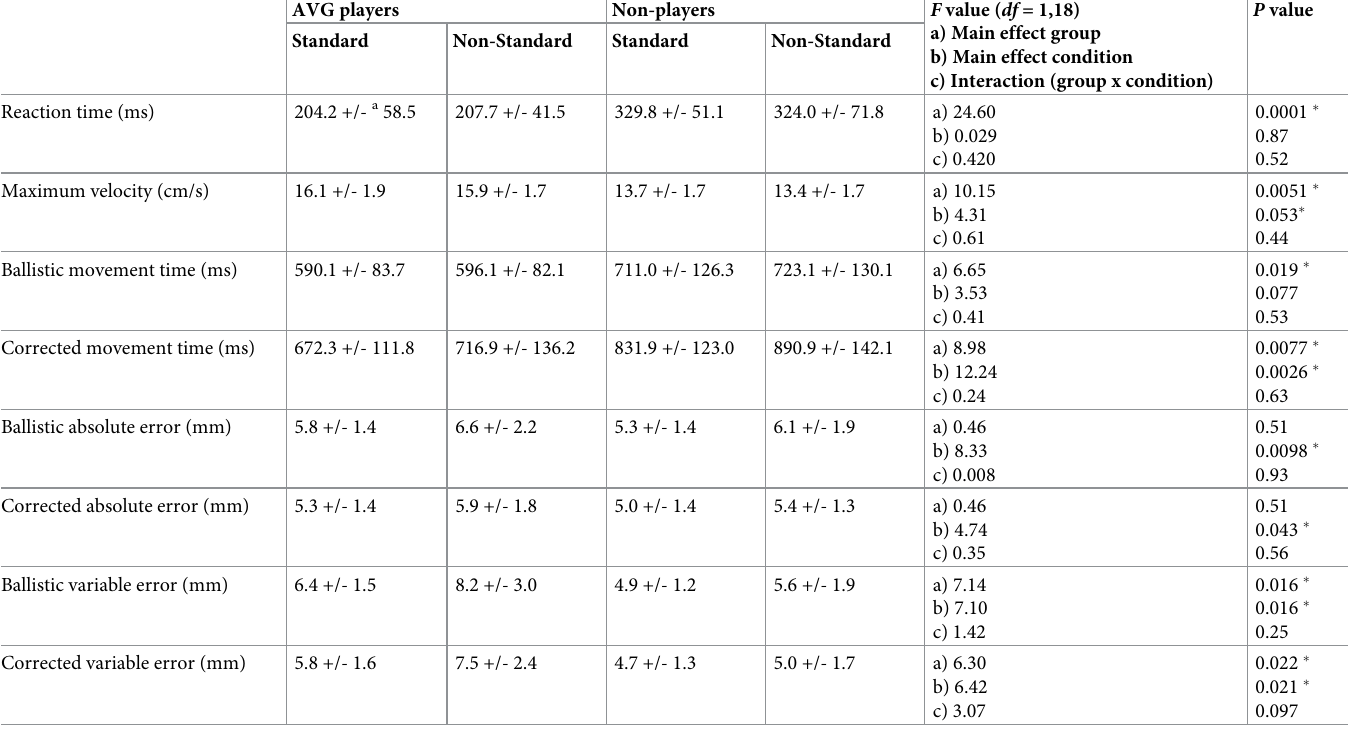
Table 4. Mean values of kinematic measures collected in Experiment 2 in the AVG player and non-player groups for the standard and non-standard visuomotor mapping conditions.